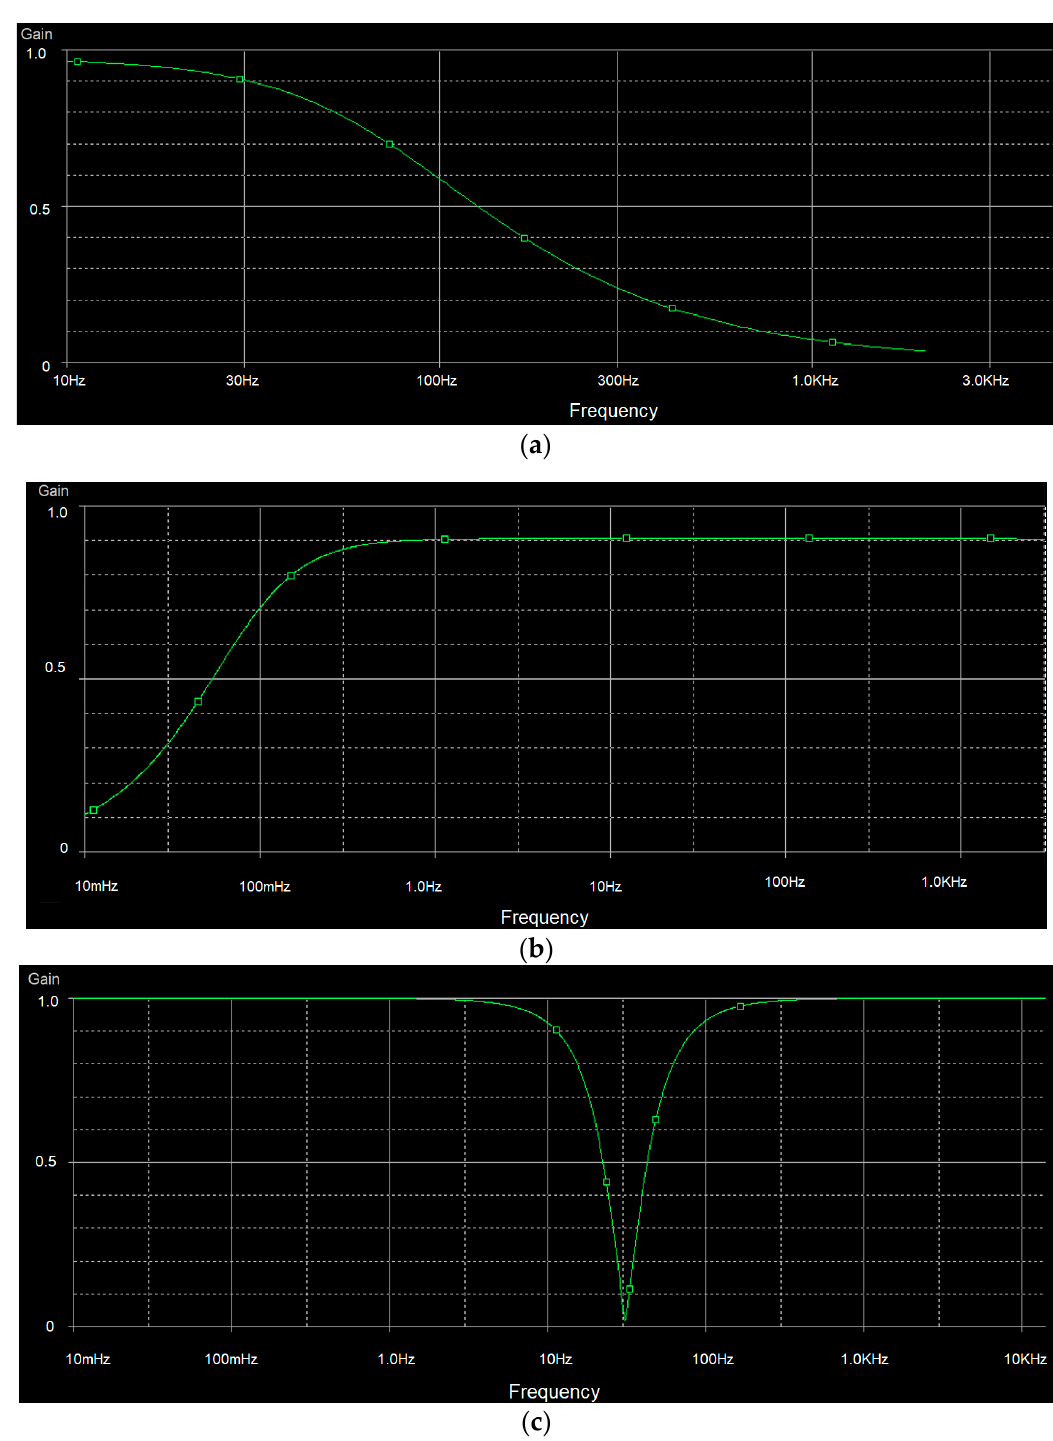
Figure 9. ( a ) Frequency response of 100-frequency cutoff low-pass filter, ( b ) frequency response of 0.01-frequency cutoff high-pass filer and ( c ) frequency response of 50 Hz notch filer.